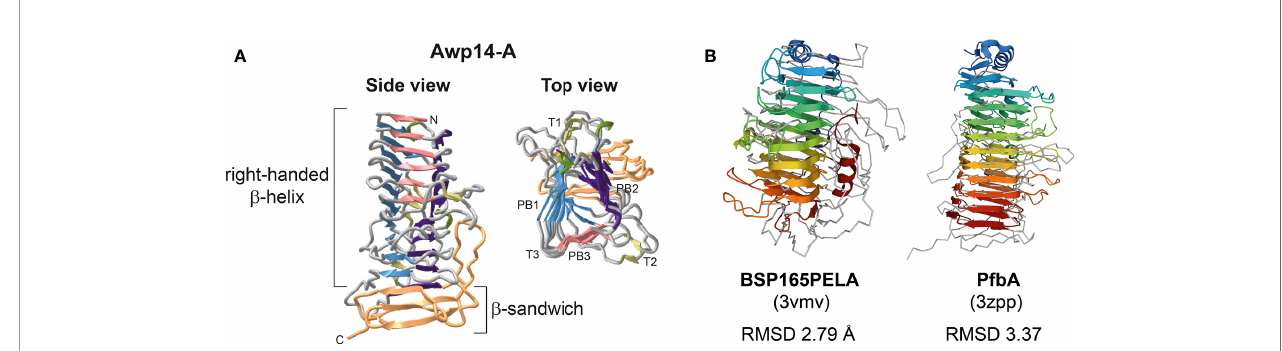
FIGURE 5 | The modeled 3D structure of the N-terminal ligand-binding domain of Awp14 shows a b -helix structure with similarity to bacterial polysaccharide lyases and adhesins. (A) Cartoon presentations of the 3D structural model of the Awp14 A-domain (residues 22 - 400). Indicated are the b -helix and C-terminal b -sandwich structure. The three b -strands forming a single turn in b -helices are referred to as PB1, PB2, and PB3, and the loops between them are labeled T1, T2, and T3 (Yoder and Jurnak, 1995). (B) Structural superposition of the Awp14 A-domain (grey ribbon) with bacterial b -helix proteins colored from the N-terminus (blue) to the C-terminus (red): the secreted pectate lyase Bsp165PelA from Bacillus sp. N16-5 (Zheng et al., 2012), and the wall-associated adhesin PfbA from S. pneumoniae (Suits and Boraston, 2013). The RMSD values after superposition were calculated for the respective b -helix domains